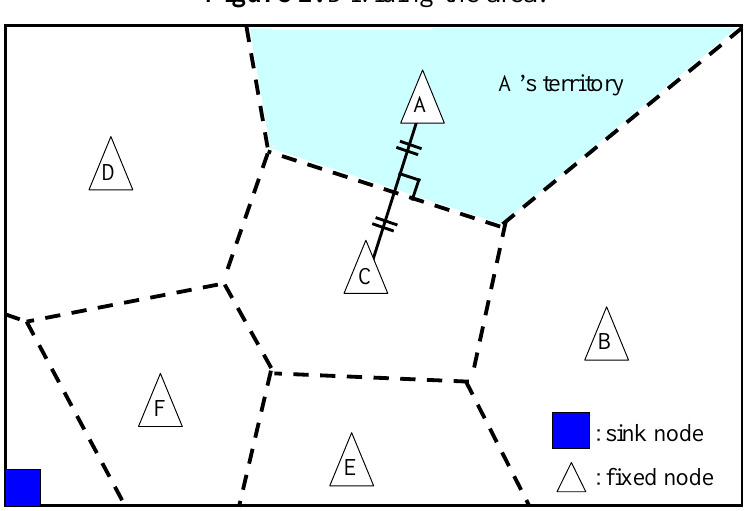
Figure 2. Dividing the